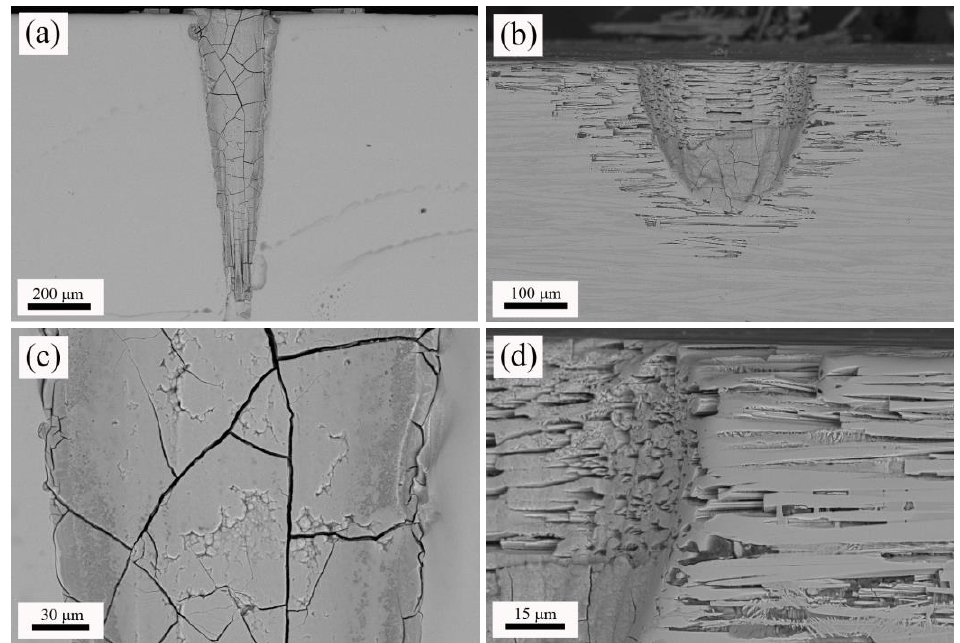
Figure 5. Cross-section micrographs of the machined glass ( a ) and glass-ceramic ( b ) after 2 months immersed in SBF, and details of the microstructure of the processed area in the glass ( c ) and glass-ceramic ( d ).